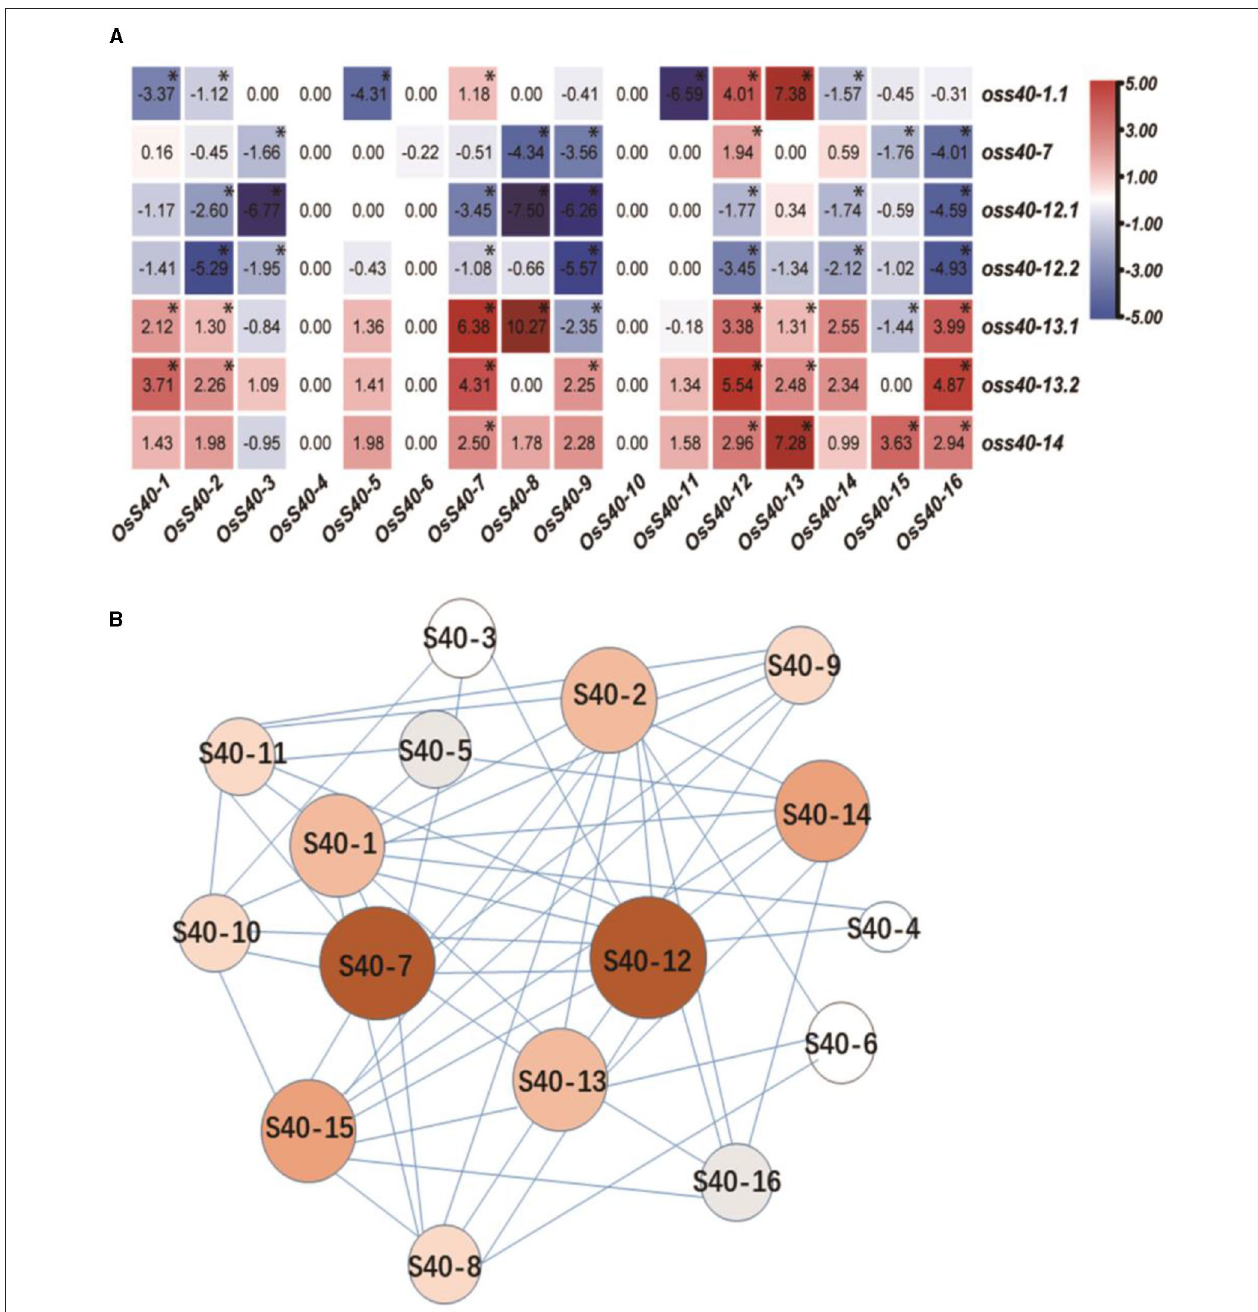
FIGURE 9 | The co-expression and regulatory network inside the S40 family. (A) Heatmap representation shows OsS40 expression levels in oss40 ( − 1, − 7, − 12, − 13, and − 14) mutant lines. The expression levels of genes are presented using fold-change values log2 format. The data indicate the relative expression levels normalized to that of the internal control OsACTIN . Red and blue colors correspond to up- and down-regulations of the gene expressions, respectively. Mean and SD values were obtained from three biological replicates. Significant differences of the expression levels normalized to WT were evaluated using Student’s t -test (* p < 0.05). (B) Structure of the co-expression network in the S40 family. In this network, the red nodes represent more associations with other members; the white nodes represent fewer associations with other members, indicating the alteration of other member gene expression in one